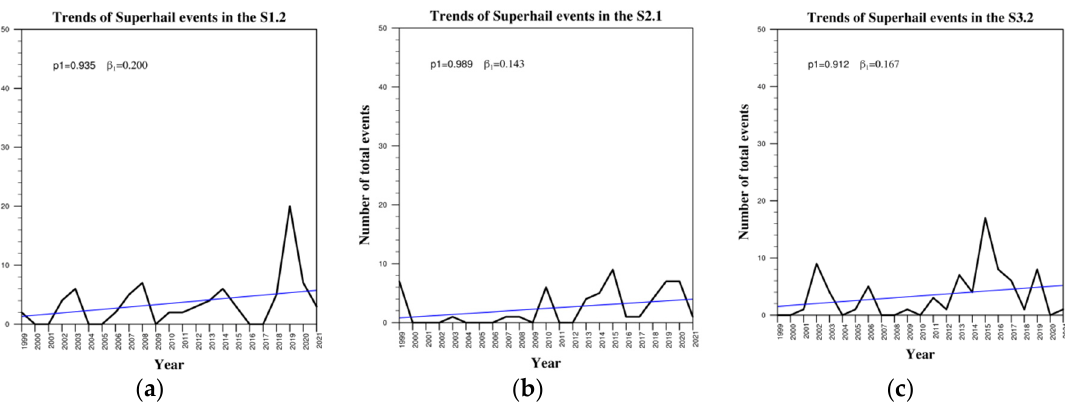
Figure 13. Temporal evolution of the annual number of SH events for the sectors 1.2 ( a ), 2.1 ( b ) and